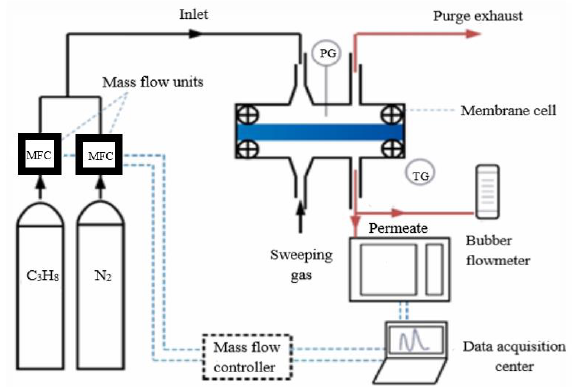
Figure 2. Illustration of membrane performance online evaluation device.